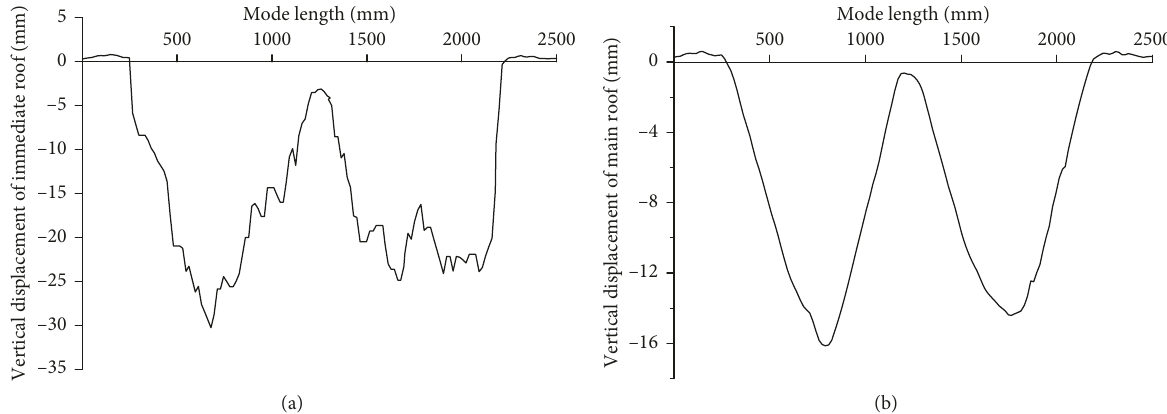
Figure 10: Rock movement characteristics during excavation of working face: (a) the sinking curve of immediate roof; (b) the sinking curve of main roof.